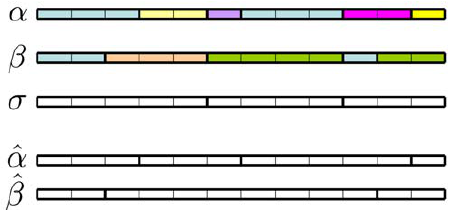
Figure 5. Reduction. Two partitions a and b (derived from sequences as given in the text) and their maximal common factor s . Thick vertical lines individuate the atomic segments. Below, the reduced partitions ^ aa and ^ bb . Colors in a and b remind the source configurations. There are no colors in s , ^ aa and ^ bb because these partitions do not originate from sequences of symbols but are directly defined in the partition